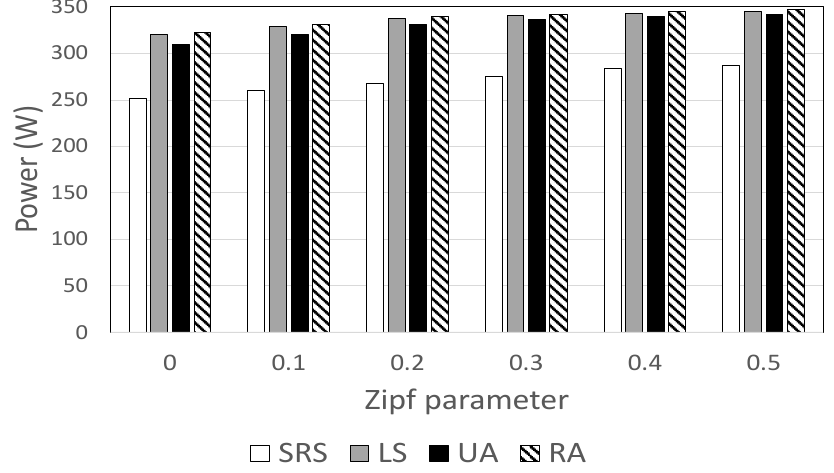
Figure 6. HDD power consumption against Zipf parameters.